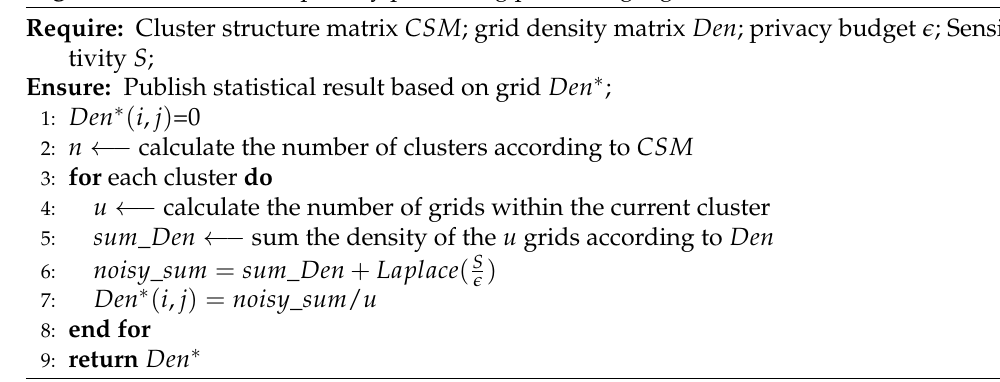
Algorithm 2 Differential privacy preserving publishing